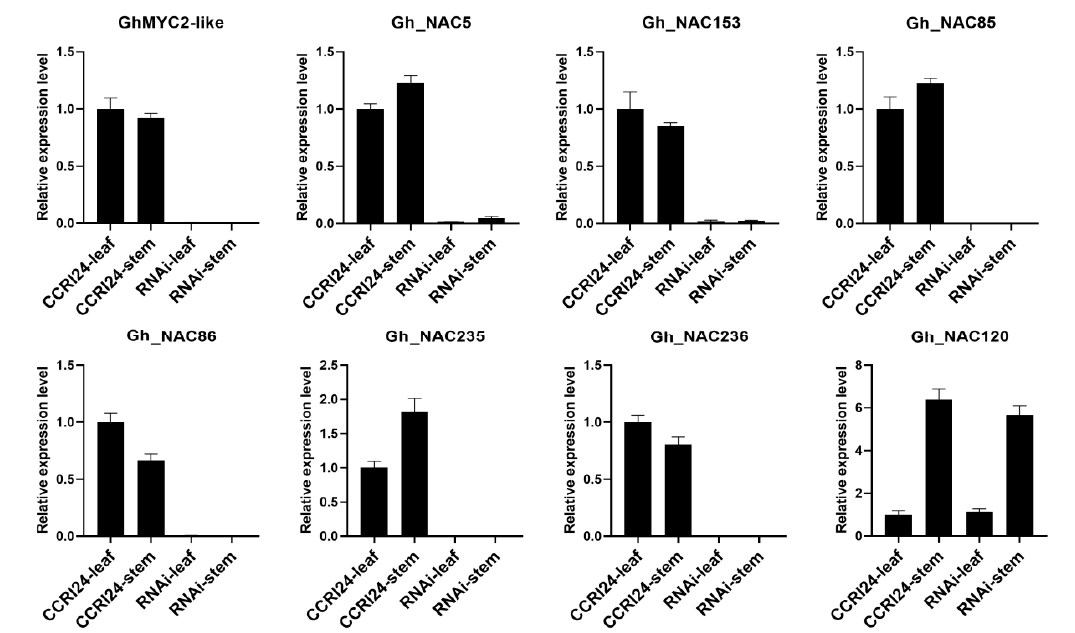
Figure 6. QRT-PCR analysis of GhMYC2-like and 7 NAC genes in CCRI24 and RNAi plants (reference gene: actin).